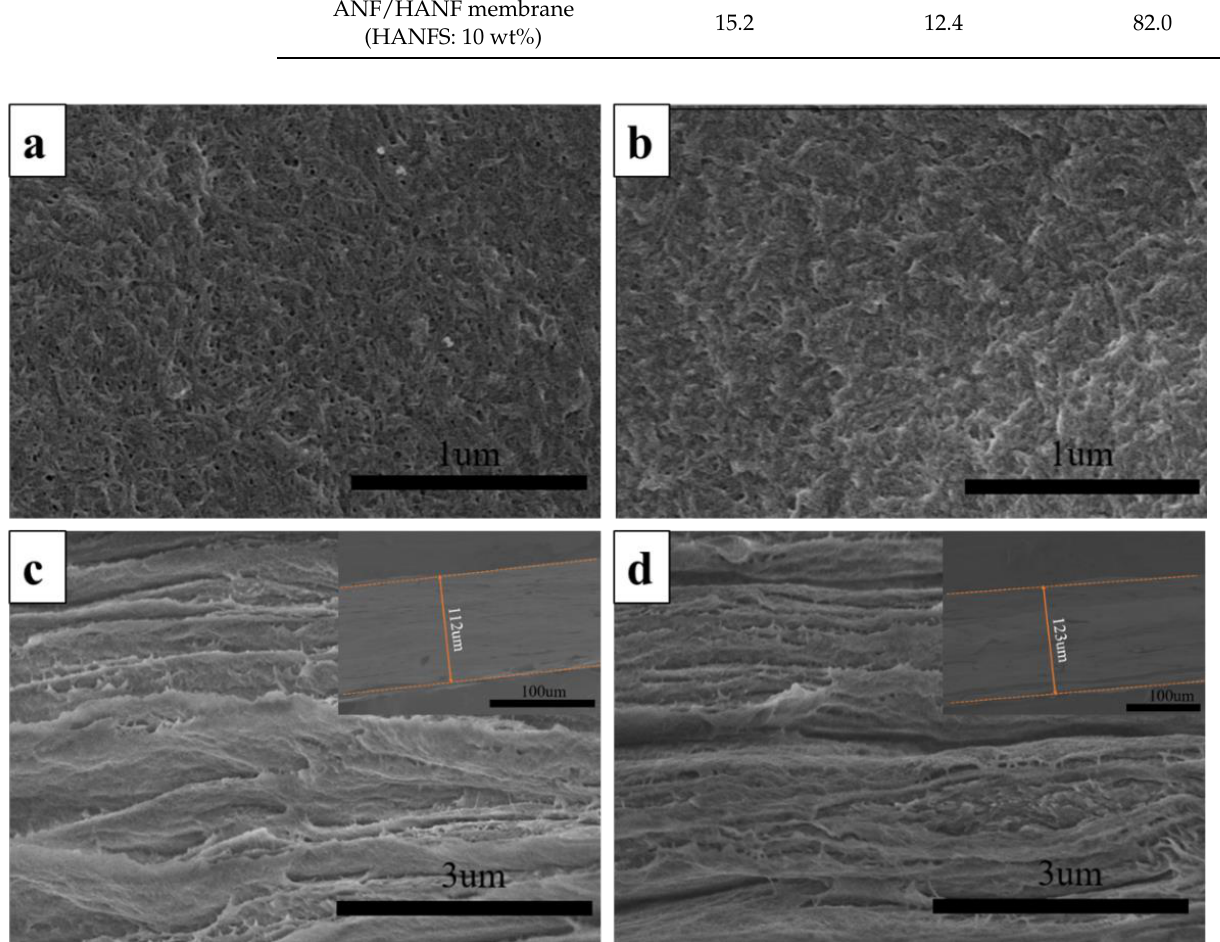
Figure 4. ( a , b ) The surface SEM images of an ANF membrane and an ANF/HANF membrance (HANF composition: 10 wt%), ( c , d ) SEM images of the cross-sectional of ANF membranes and ANF/HANF membranes (HANF composition: 10 wt%).